Question: What kind of plot is shown here?
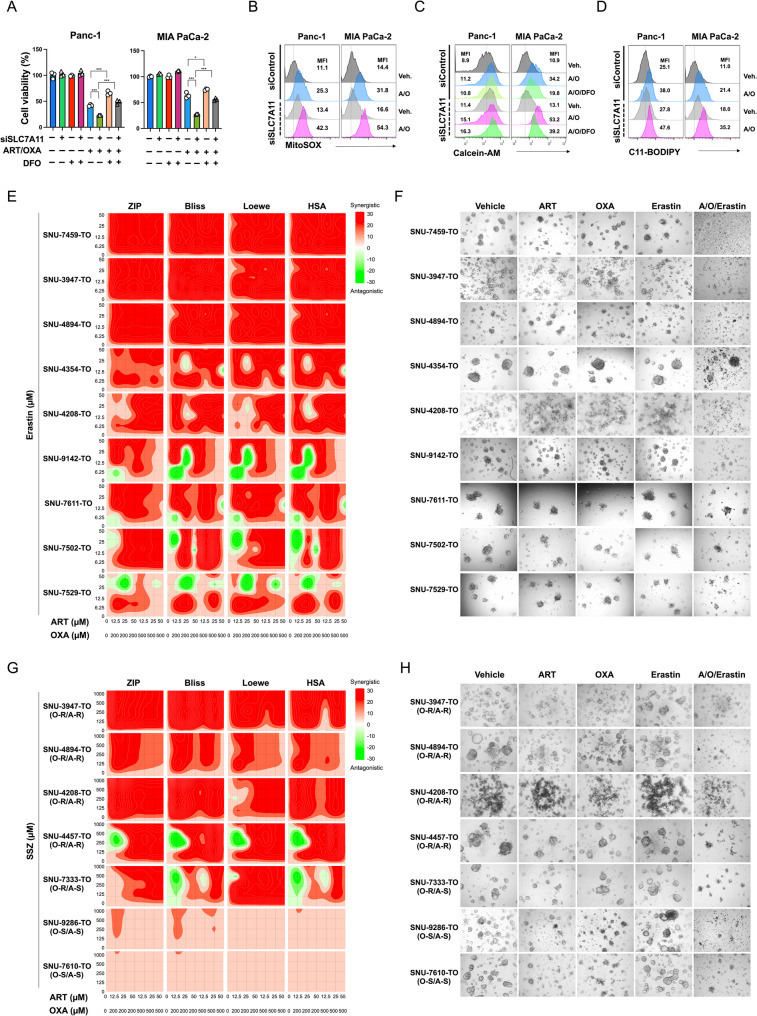
Answer: histogram